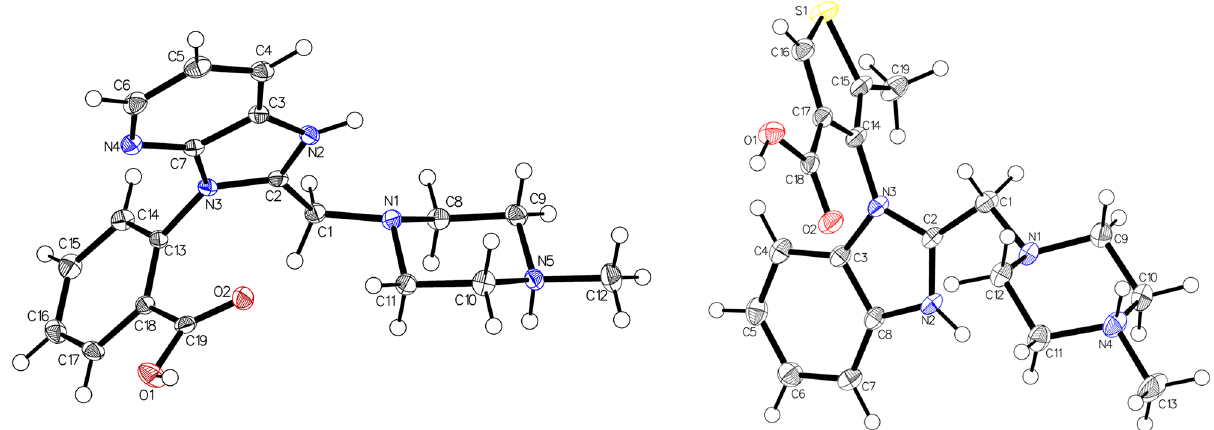
Figure 2. Crystal structure of 4 (left) and 5 (right), drawn with 50% displacement ellipsoid. The bond precision for C–C single bonds is 0.0017 Å ( 4 ) and 0.0039 Å ( 5 ), respectively (Supplementary Tables S5–S8). Solvent omitted for